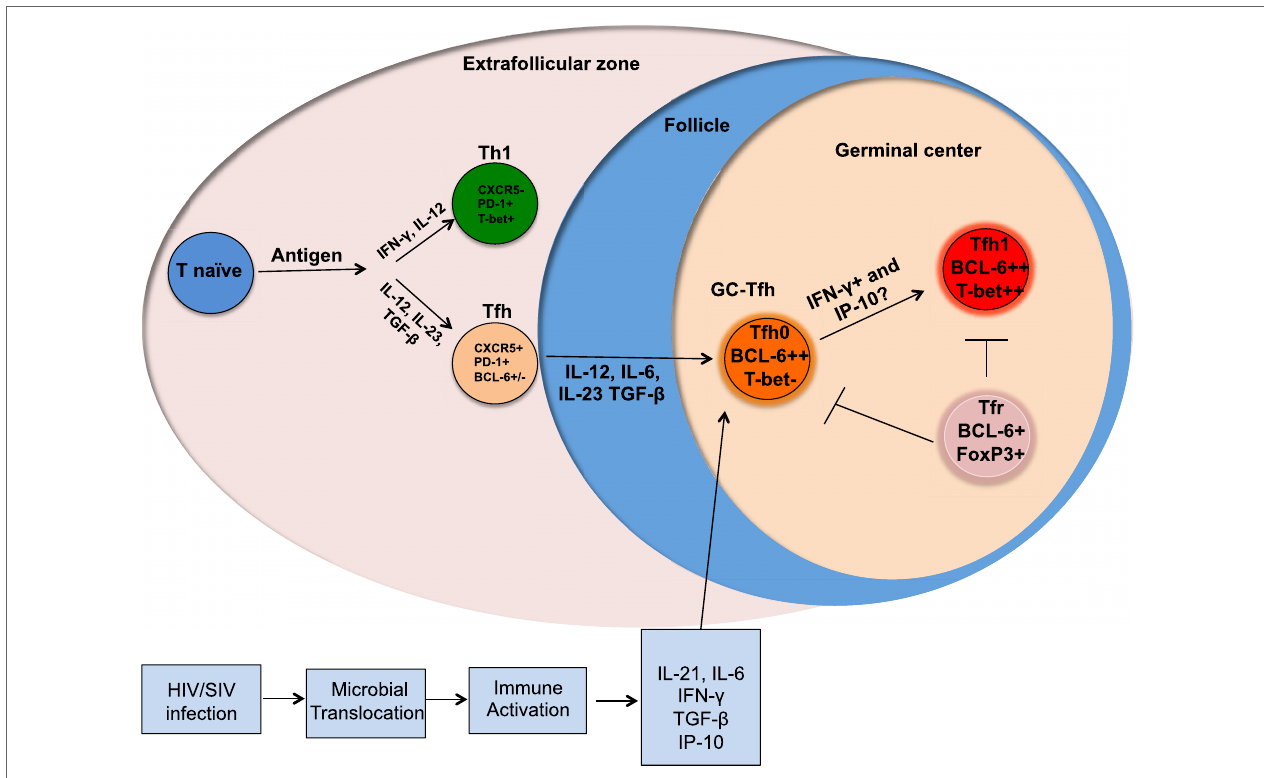
FiGURe 1 | Altered differentiation of Tfh cells during chronic HIV/SIV infection. Following antigenic stimulation naïve CD4 T cells differentiate into different helper T cells and the presence of cytokines, such as IL-12, IL-23, and TGF β promote differentiation into Tfh cells. Upon further interaction with B cells, these Tfh differentiate into germinal center (GC)-Tfh and migrate to GC. GC-Tfh can further differentiate into Tfh1 cells that can be mediated by the high levels of IFN γ and IP-10 produced during chronic HIV/SIV infection. The GC-resident Tfr cells can regulate the magnitude and function of